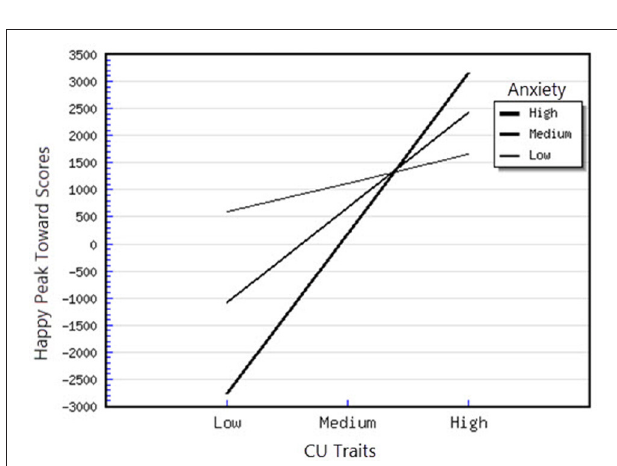
FIGURE 6 | Interaction between CU traits and anxiety in predicting happy peak toward scores.